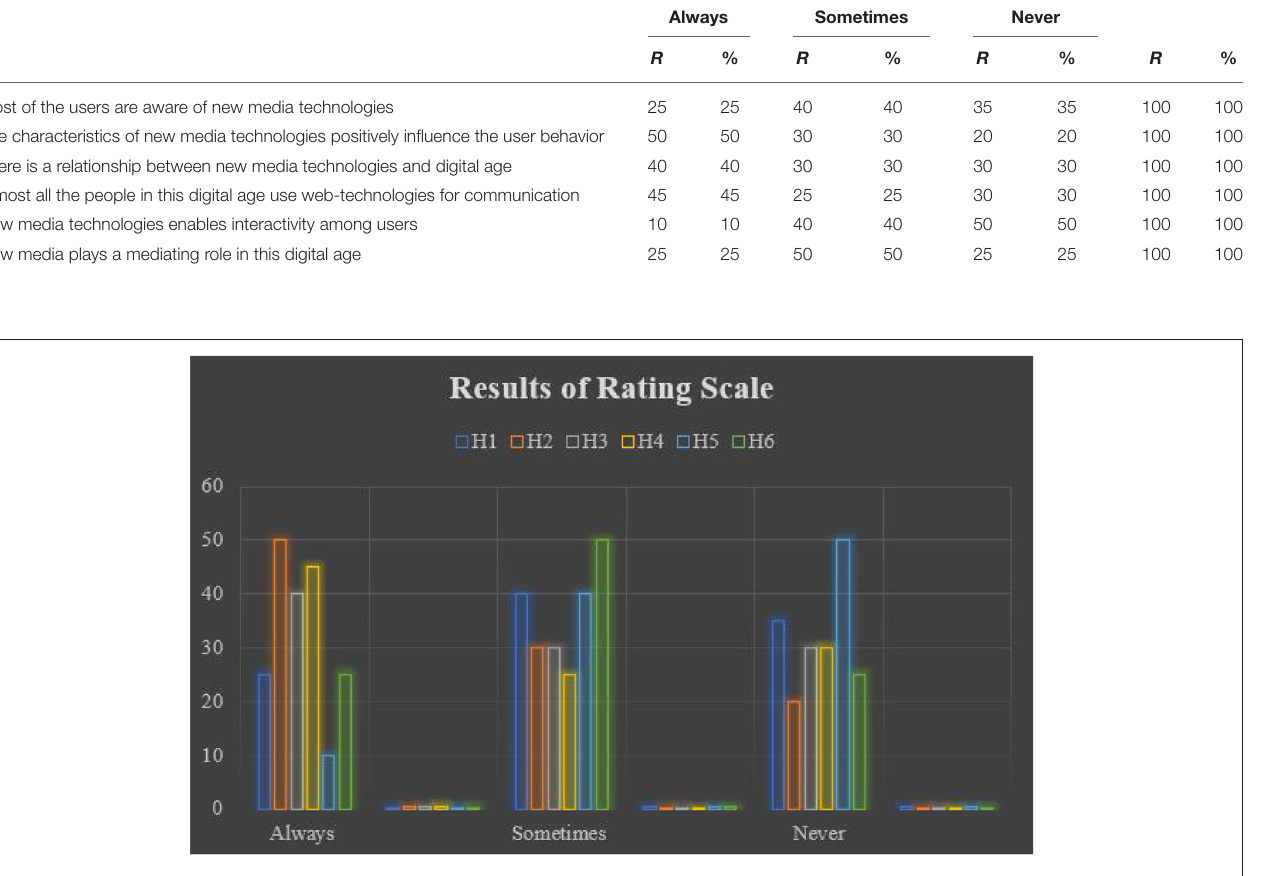
FIGURE 4 | Graphical representation of rating scale